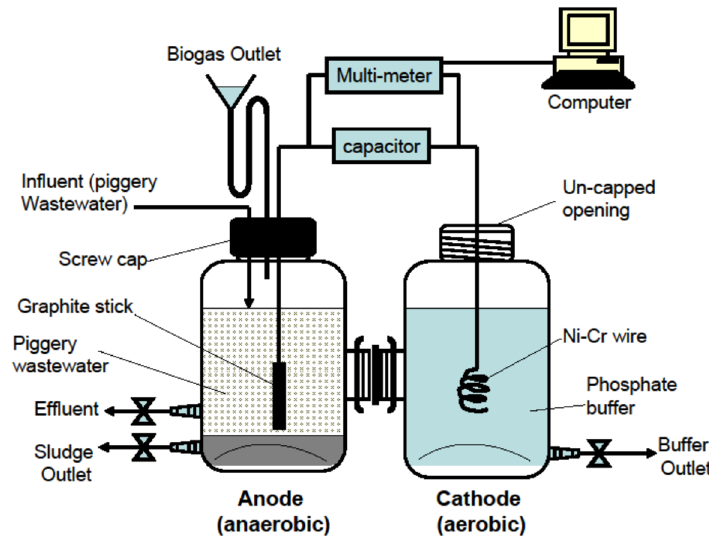
Figure 1. Design of the simple two-chamber microbial fuel cell.